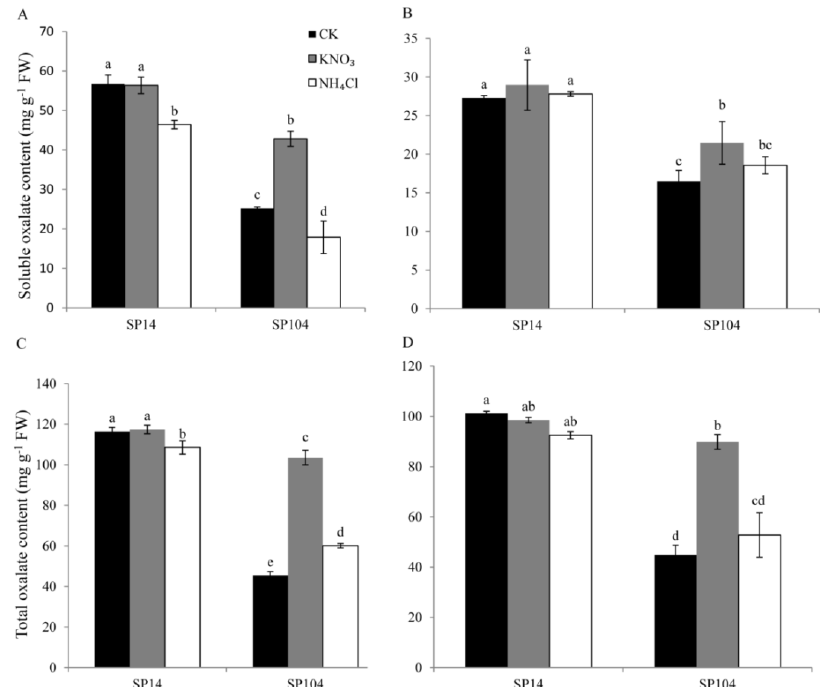
Figure 3. Contents of soluble oxalate ( A , B ) and total oxalate ( C , D ) in the leaf laminas ( A , C ) and leaf petioles ( B , D ) of two spinach cultivars in response to NH 4+ and NO 3− treatments. Error bars represent standard deviation among three independent replicates. The data are the means of three replicates ±SD. Different letters (a, b, c, or d) indicate significant differences at P <0.05.